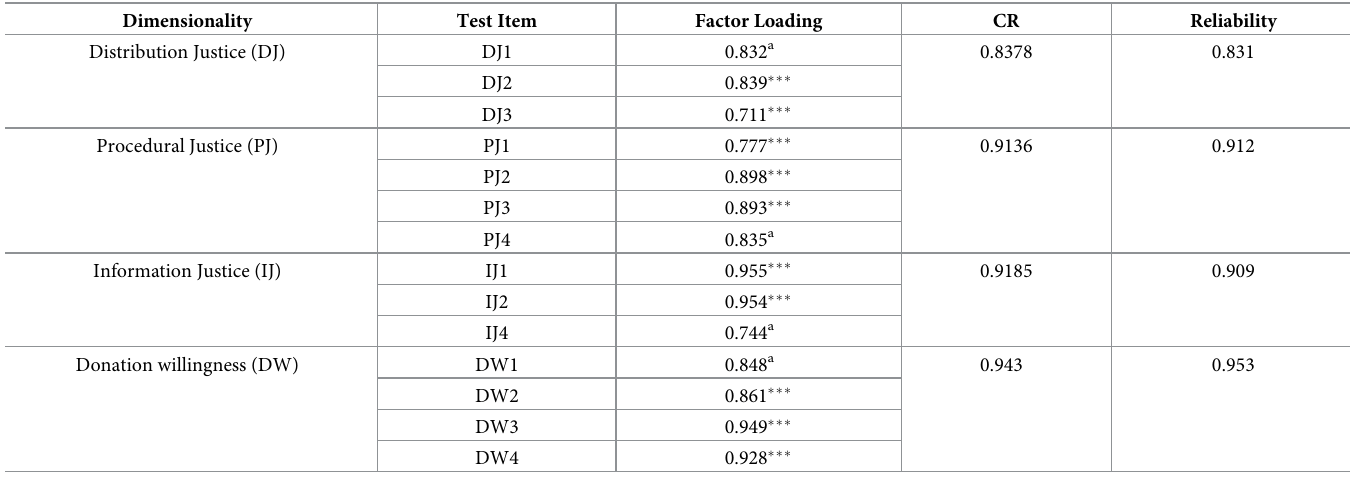
Table 7. Confirmatory factor analysis.